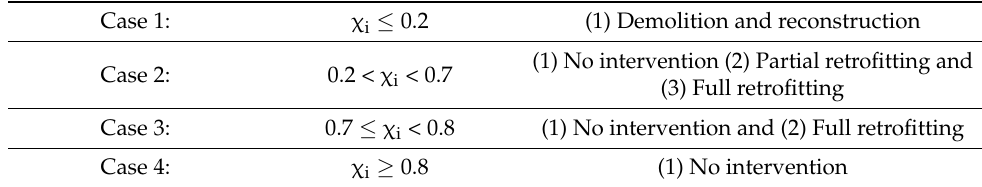
Table 1. Decision solutions according to the initial vulnerability